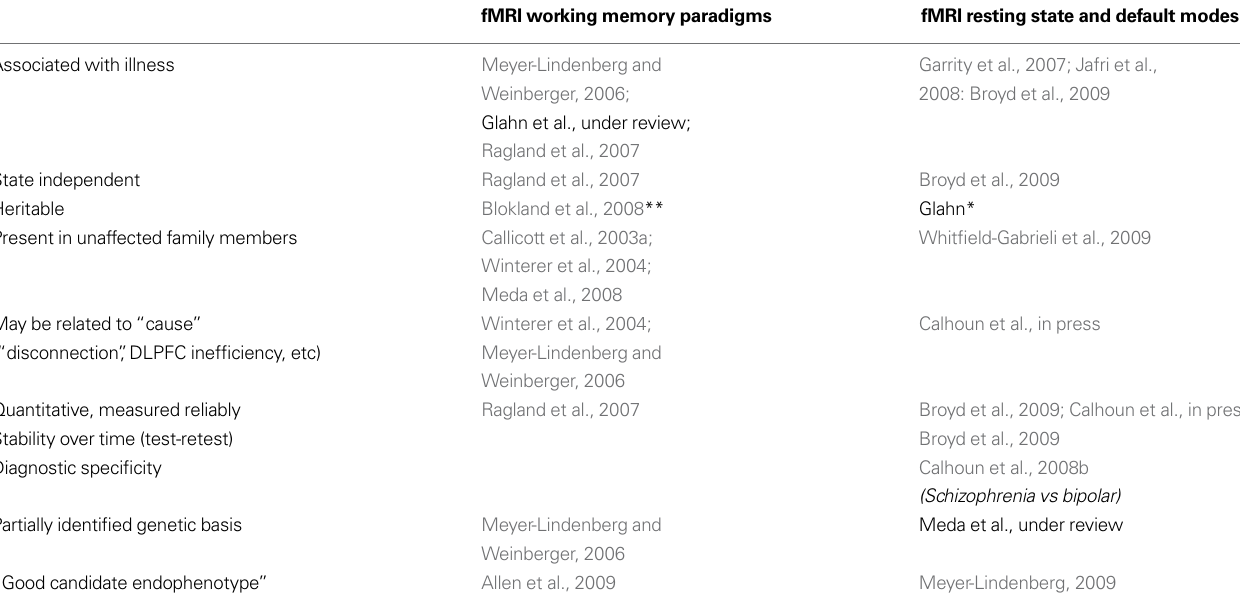
Table 1 | Comparison of endophenotypic properties of working memory and default mode/resting state studies in schizophrenia and